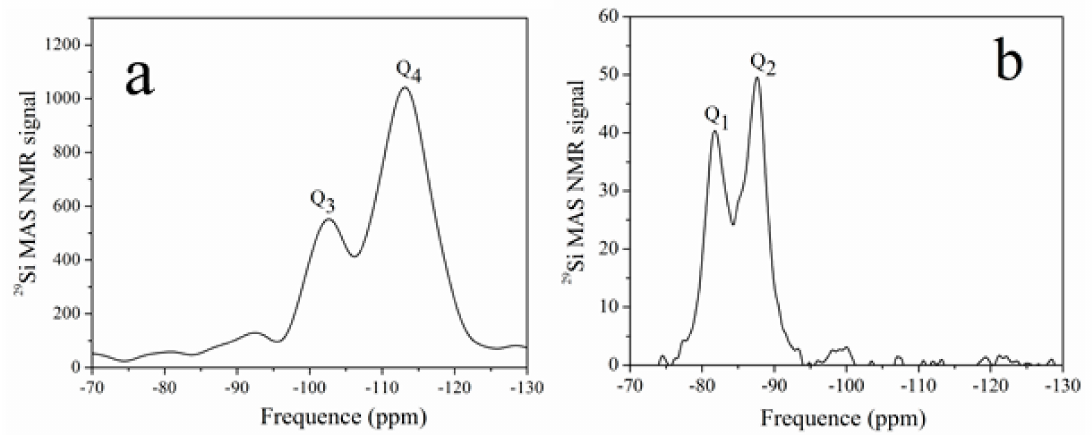
Figure 6. NMR spectra of Sample 2 ( a ) and its reaction production ( b ) with Ca(OH) 2